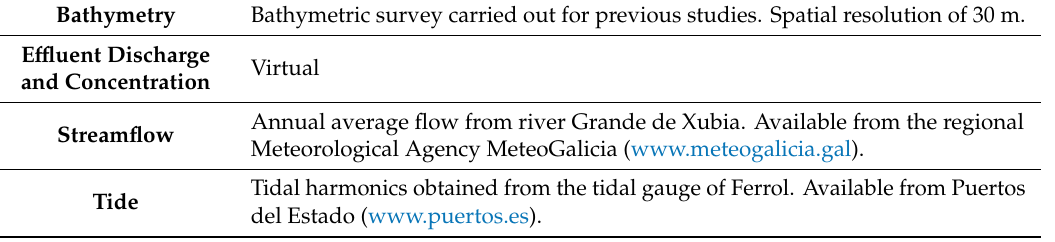
Table A1. Data sources for the Test Case 1.